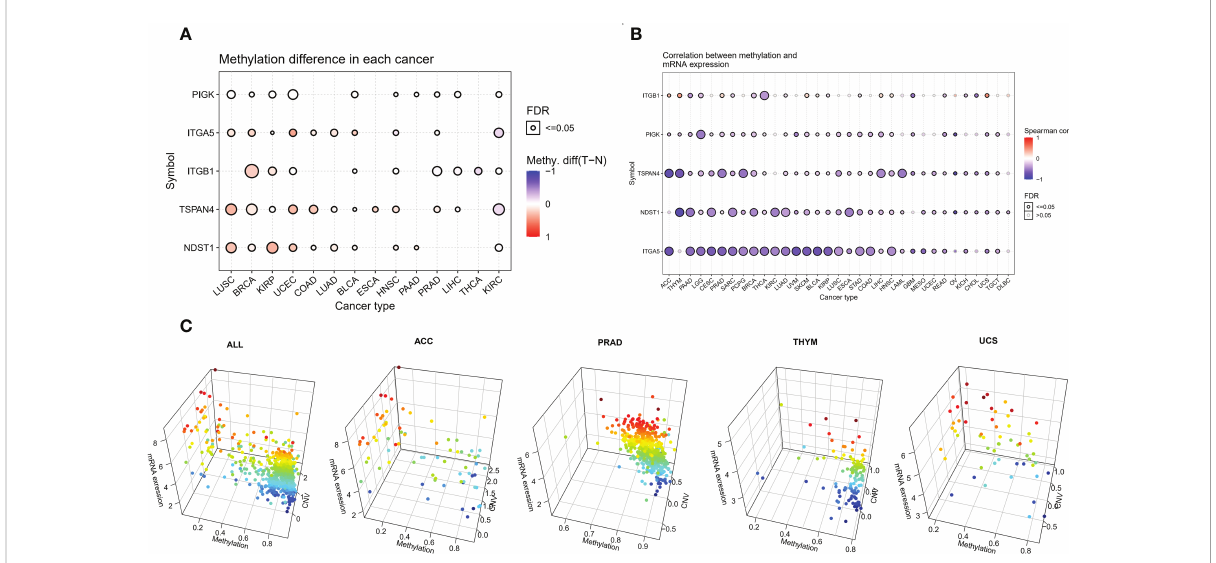
FIGURE 3 Aberrant methylation of MRGs in pan-cancer. (A) The methylation levels of MRGs between tumor and normal samples for each cancer. Blue dots indicate low tumor methylation levels and red dots indicate high tumor methylation levels. (B) Correlation of methylation with the mRNA gene expression. Blue dots indicate a negative correlation, while red dots indicate a positive correlation, and the deeper the color, the higher the correlation. (C) Correlation analysis of ITGB1 expression with methylation and